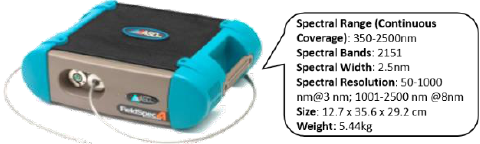
Figure 2. Picture and parameters of ASD FieldSpec4 portable